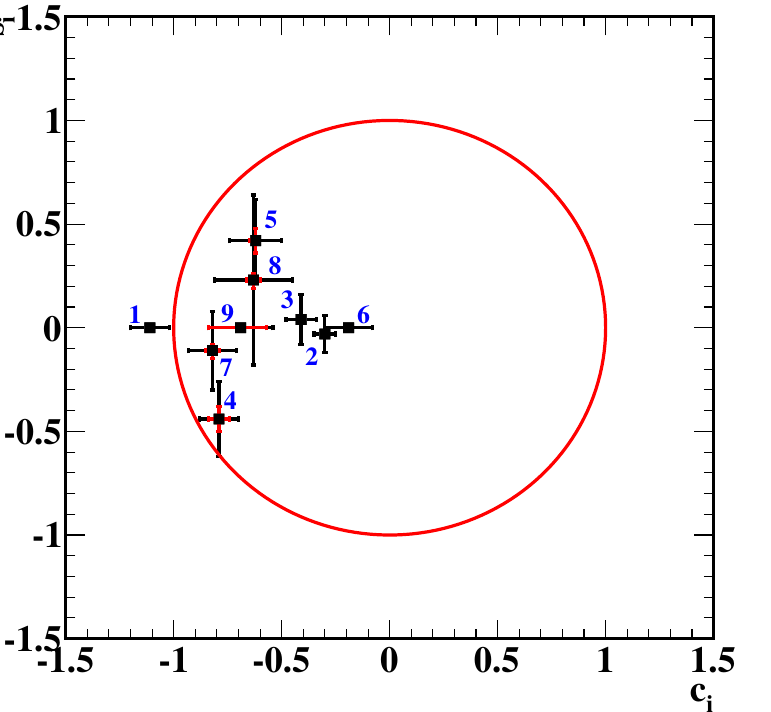
Figure 1 . Values of c i and s i reported in ref. [13]. The black and red error bars represent statistical and systematic uncertainties,